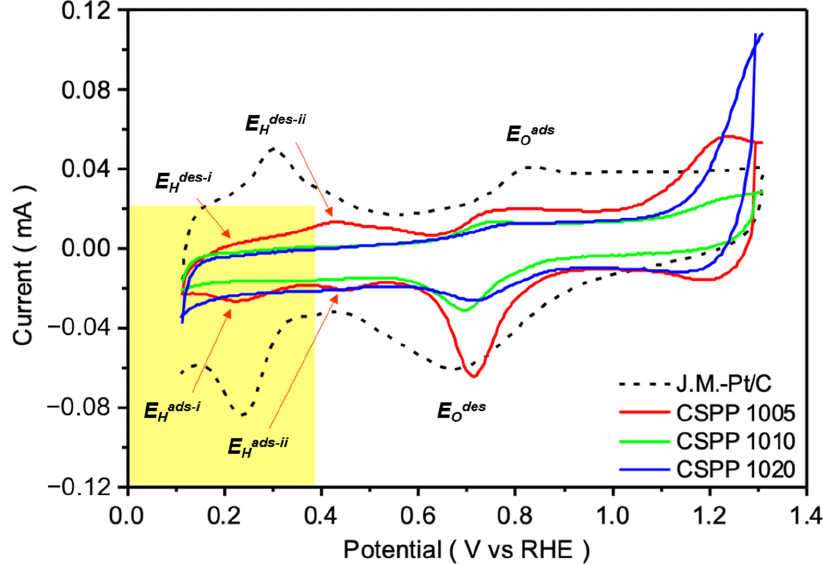
Figure 4. Cyclic voltammetry (CV) plots of CSPP NCs compared with the commercial J.M.-Pt/C NC. All the CV curves were obtained in an N 2 -saturated 0.1 M KOH electrolyte.